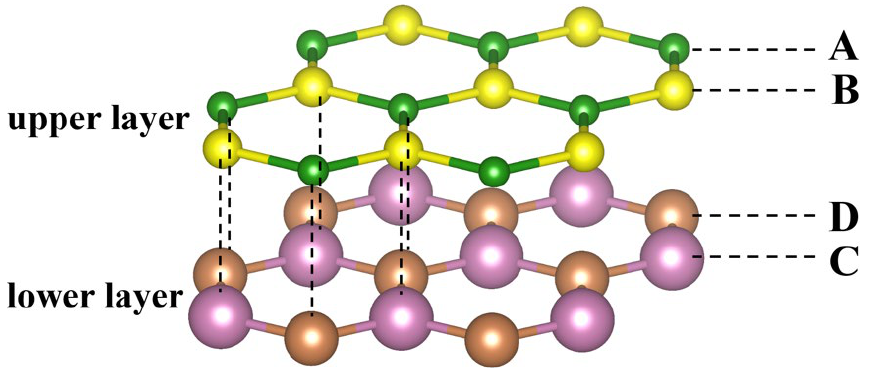
Figure 1. The crystal structure of AB/CD vdWH, where A, B, C, and D represent group III (B, Al, Ga, In, and Ta), group IV (C, Si, Ge, Sn, and Pb), and group V elements (N, P, As, Sb, and Bi).